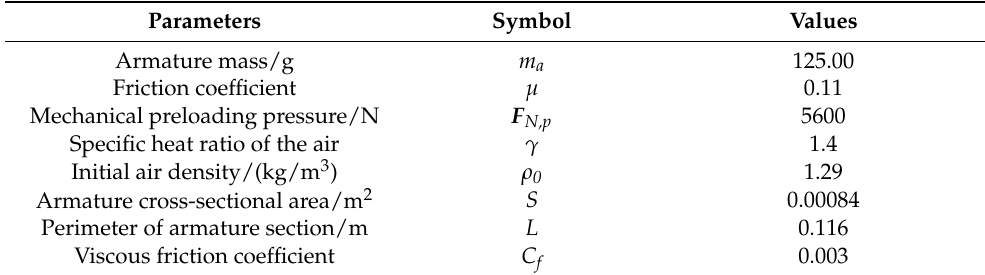
Table 2. Parameters of armature kinetic equation.